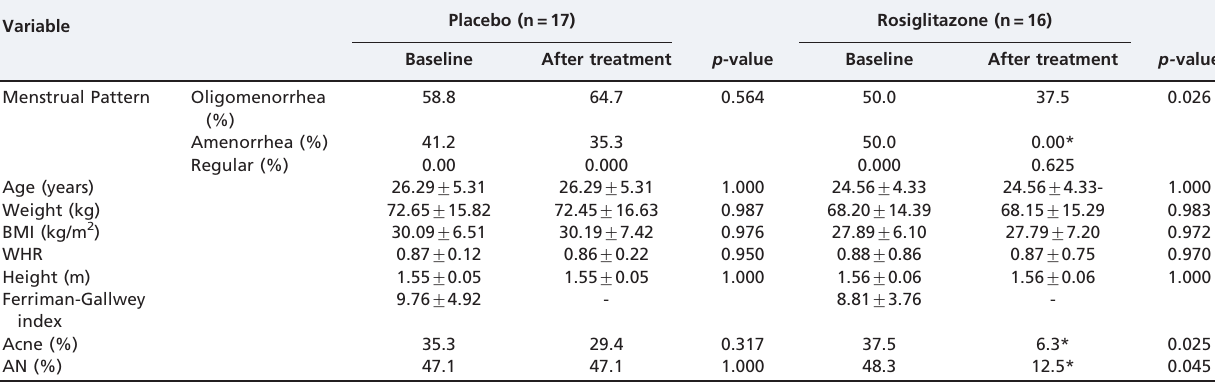
Table 1 - Clinical data for the women with PCOS in the placebo and rosiglitazone